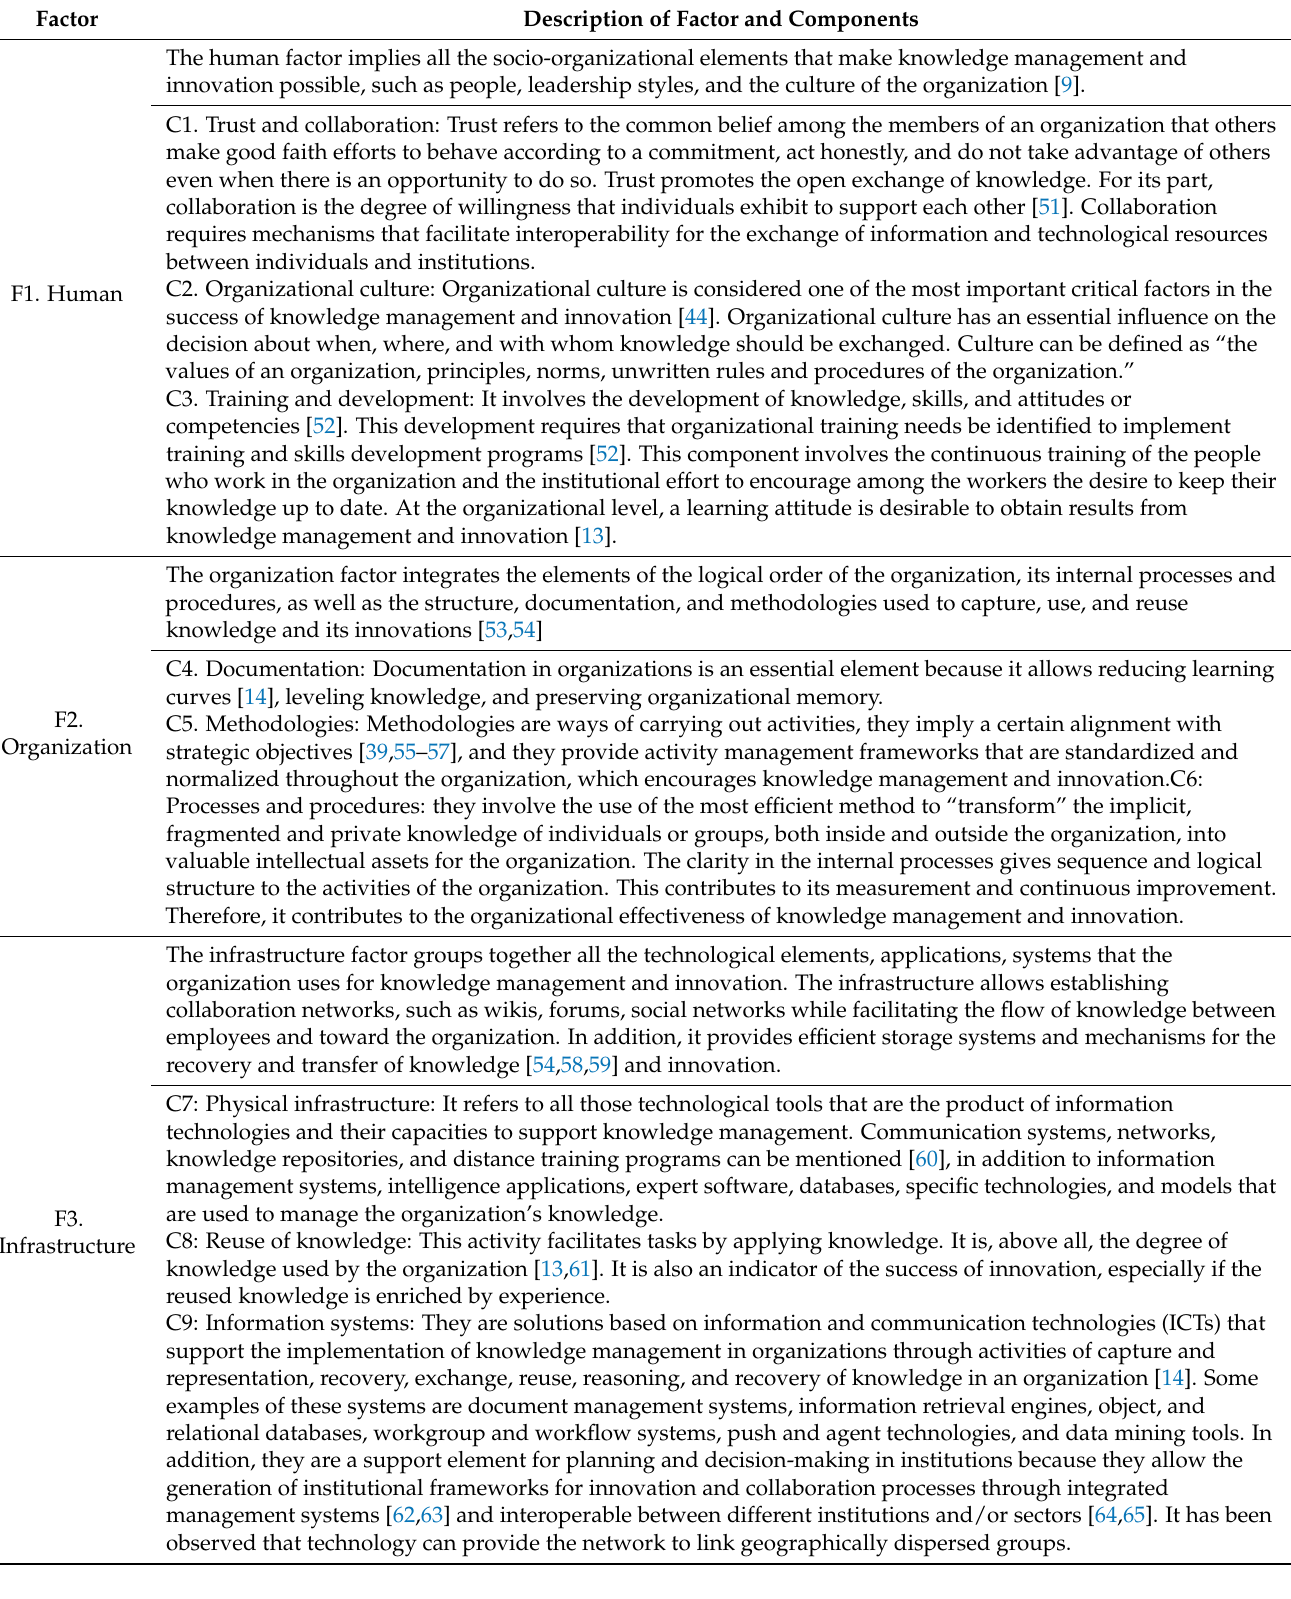
Table 4. Description of the factors and their components integrated into the